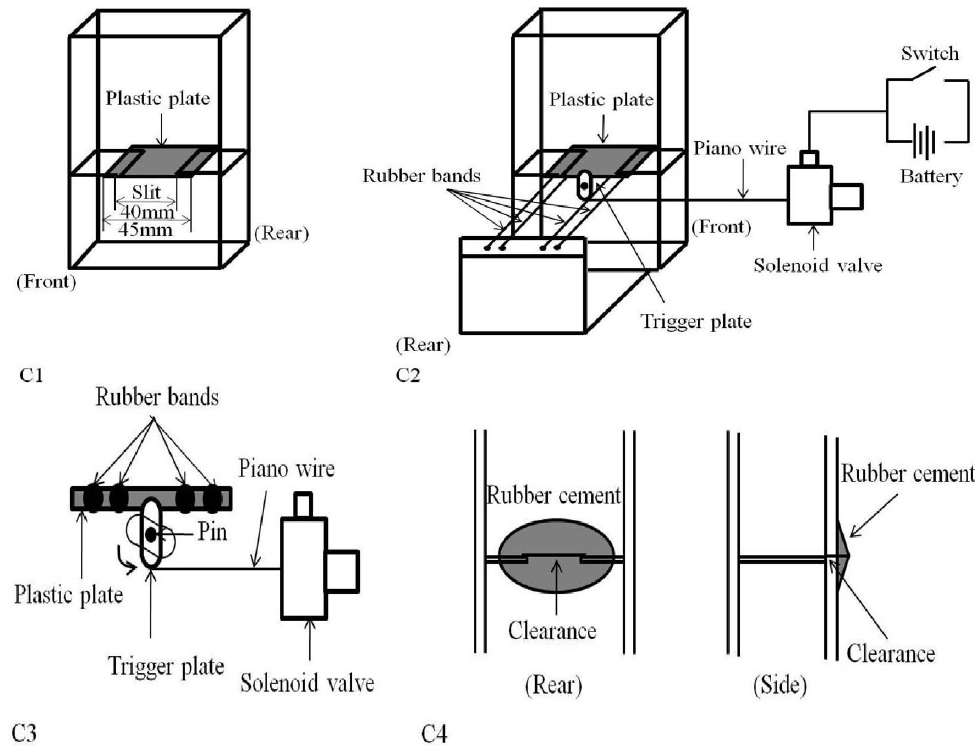
Figure A2. Apparatus for instant opening of